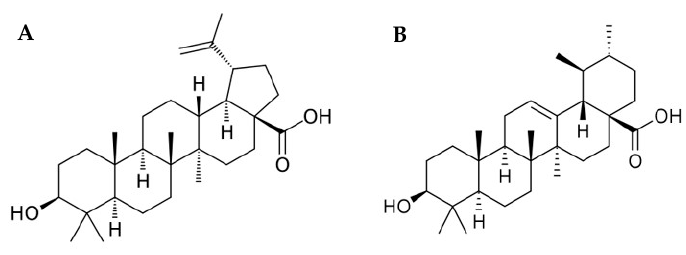
Figure 1. Structural formula of ( A ) betulinic acid and ( B ) ursolic acid.